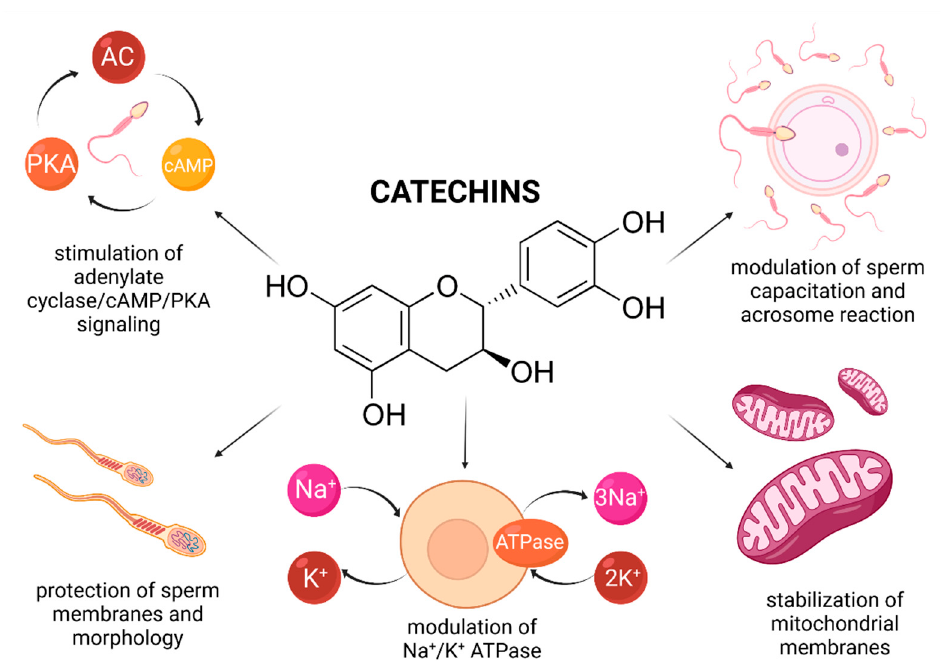
Figure 4. Most frequently reported beneficial effects of catechins on spermatogenesis, sperm struc- tural integrity and functional activity.